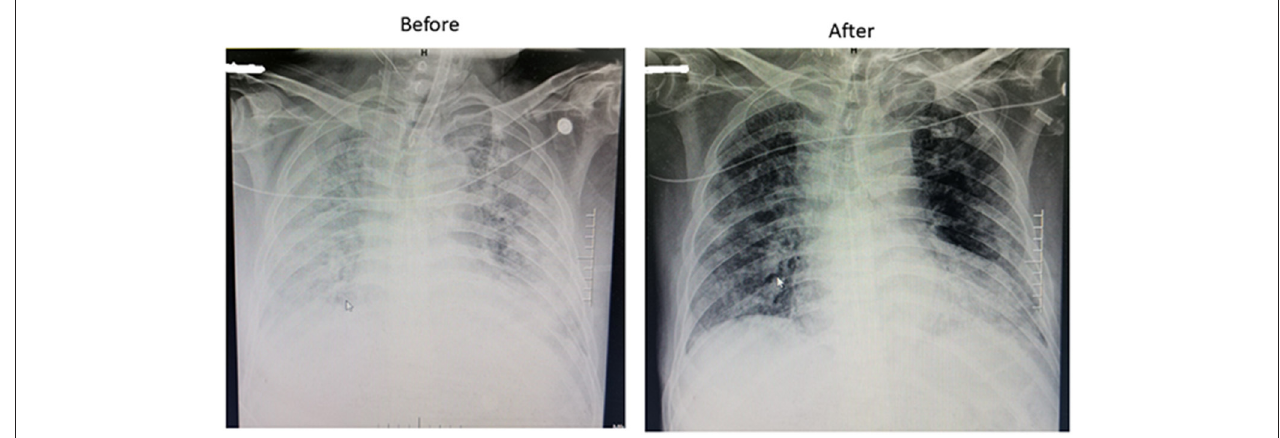
FIGURE 1 | Representative chest X-ray of COVID-19 patients before and after ECMO treatment.